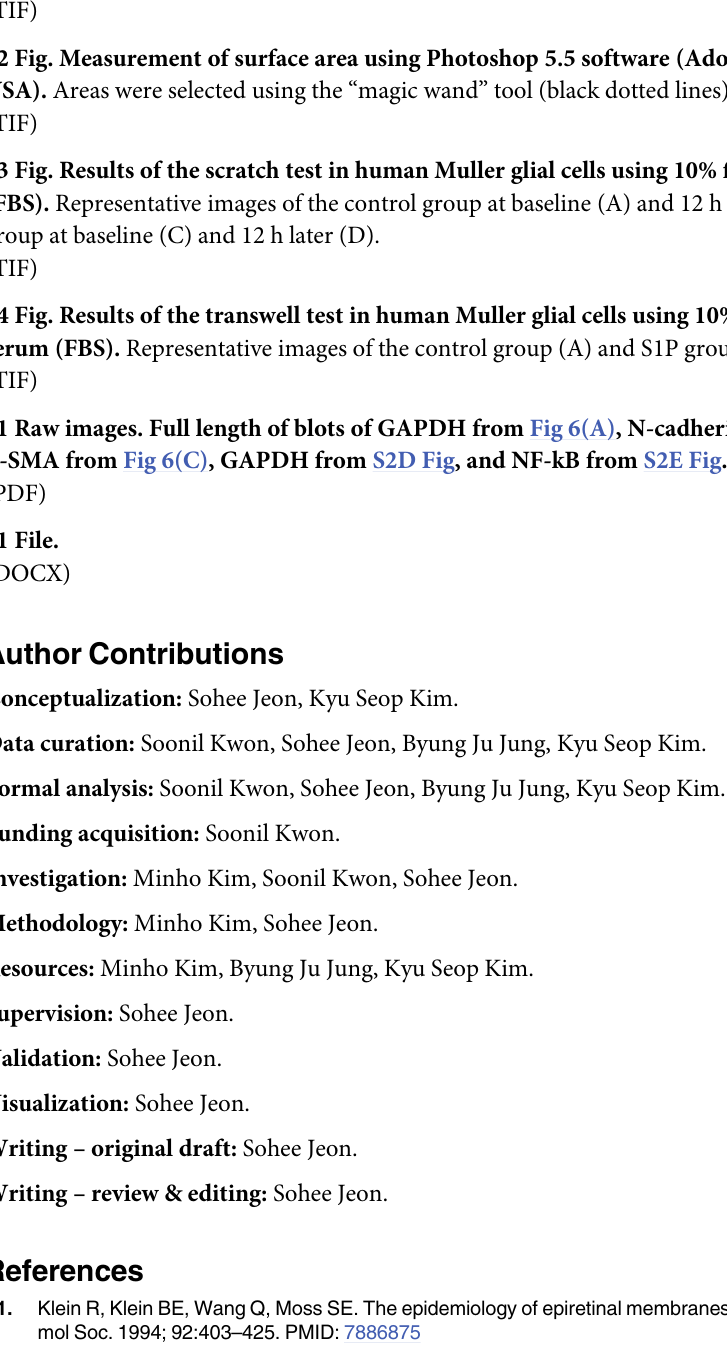
S1 Fig. Fold expression relative to GAPDH, detected by quantitative polymerase chain reac- tion of N-cadherin (A) and Western blot of NF-kB (B) according to various S1P doses. (TIF) S2 Fig. Measurement of surface area using Photoshop 5.5 software (Adobe, San Jose, CA, USA). Areas were selected using the “magic wand” tool (black dotted lines). S3 Fig. Results of the scratch test in human Muller glial cells using 10% fetal bovine serum (FBS). Representative images of the control group at baseline (A) and 12 h later (B), and S1P group at baseline (C) and 12 h later (D). S4 Fig. Results of the transwell test in human Muller glial cells using 10% fetal bovine serum (FBS). Representative images of the control group (A) and S1P group (B). (TIF) S1 Raw images. Full length of blots of GAPDH from Fig 6(A), N-cadherin from Fig 6(B), α -SMA from Fig 6(C), GAPDH from S2D Fig, and NF-kB from S2E Fig. (PDF) S1